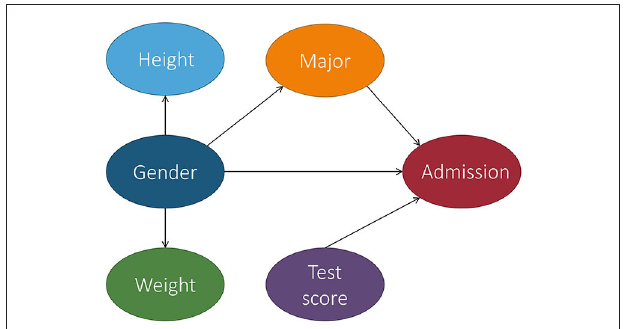
FIGURE 4 | Causal graph of the college admission example used throughout this section. Let gender be the marginalization attribute and Female be the marginalized class. For simplicity, we consider gender to be binary, but we recognize that this is not the case in real life.